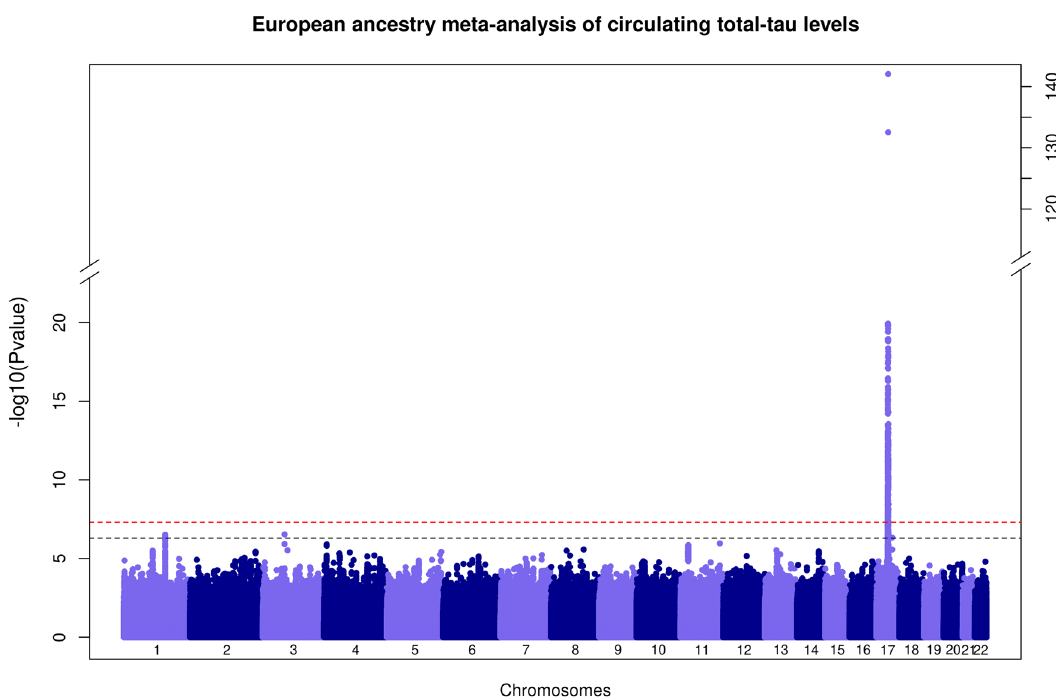
Fig. 2 Manhattan plot of association P values for the European ancestry speci fi c meta-analysis of GWAS of circulating total-tau levels. The – log10( P )- value for each single nucleotide variant on the y axis is plotted against the build 37 genomic position on the x axis (chromosomal coordinate). The dashed horizontal red line indicates the genome-wide signi fi cance threshold of P = 5 × 10 − 8 and the dashed horizontal black line indicates the threshold of P = 5 × 10 − 7 . The y axis was truncated for ease of